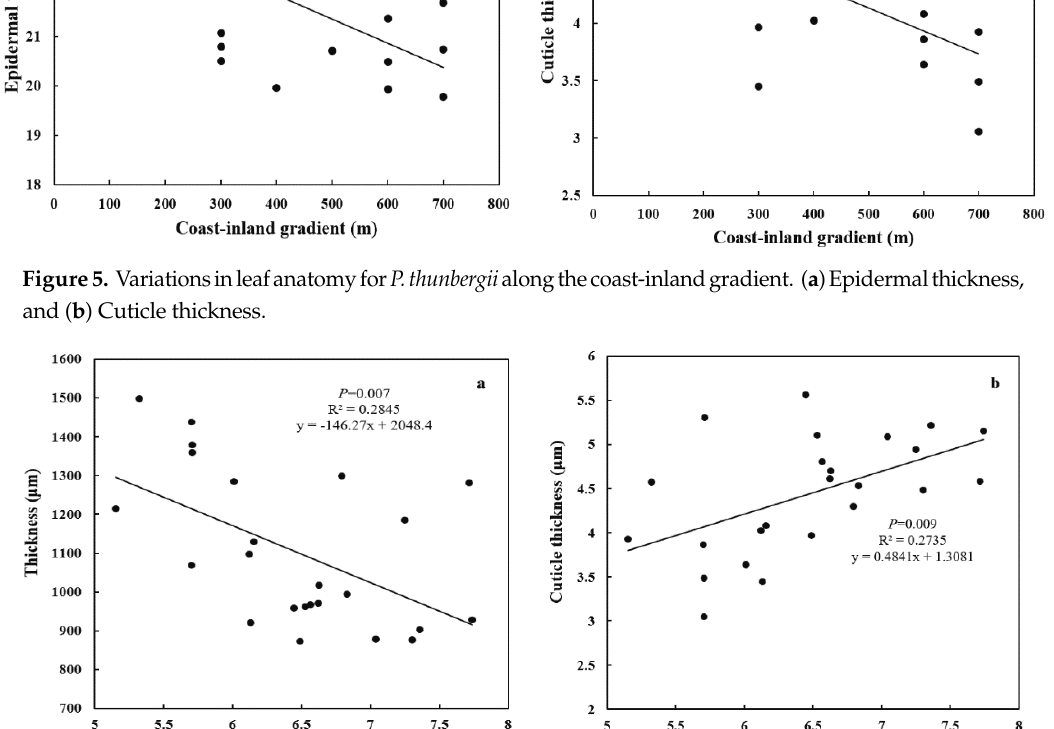
Figure 6. The relationships between leaf carbohydrate categories and morphology and anatomy for P. thunbergii along the coast-inland gradient. ( a ) Leaf thickness and SC/NSC, and ( b ) Cuticle thickness and SC/NSC.